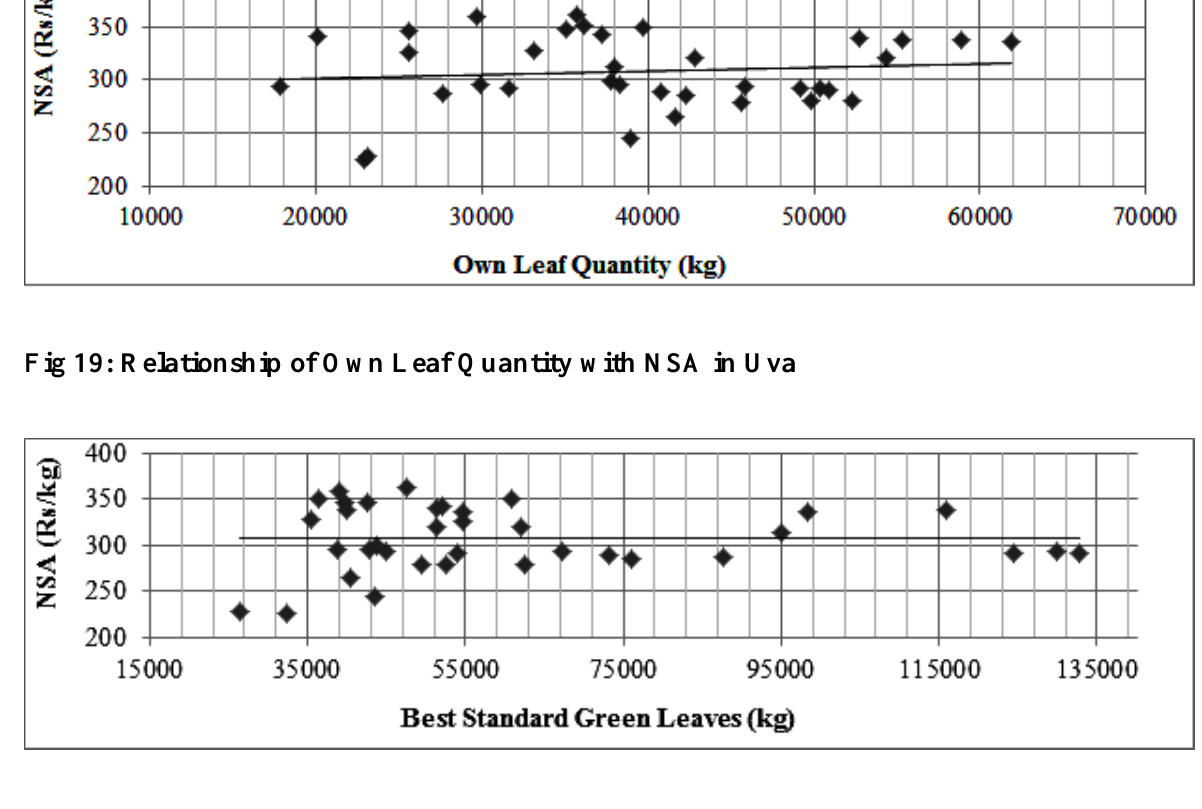
Fig 20: Relationship of Best Leaf Quantity with NSA in